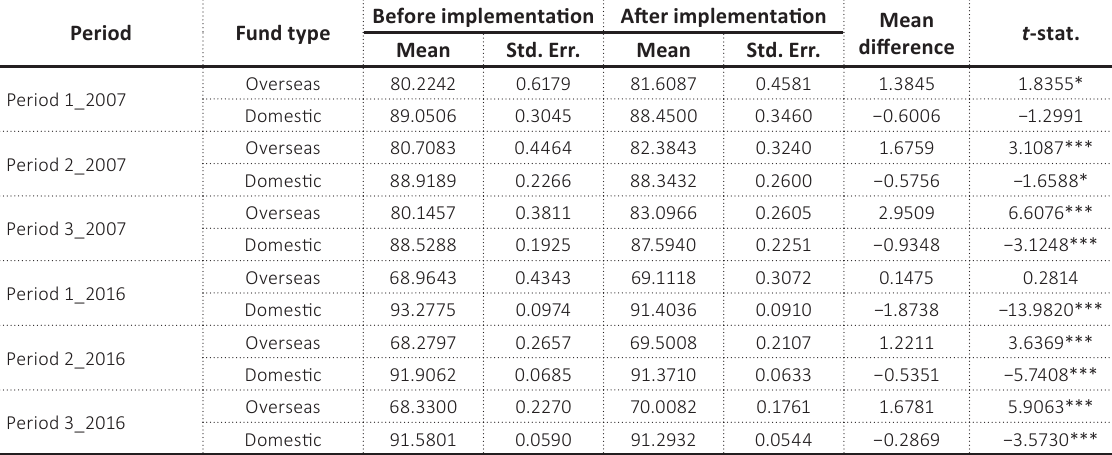
Table 5. t -test results for overseas equity and domestic fund